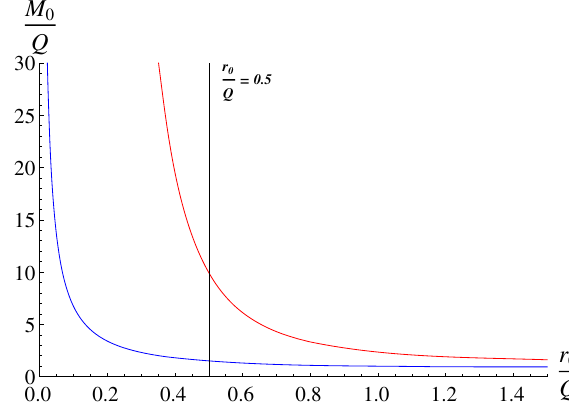
horizon radius. The red and blue curves refer to the non-linear charged black hole of this work and the RN-AdS black hole, respectively